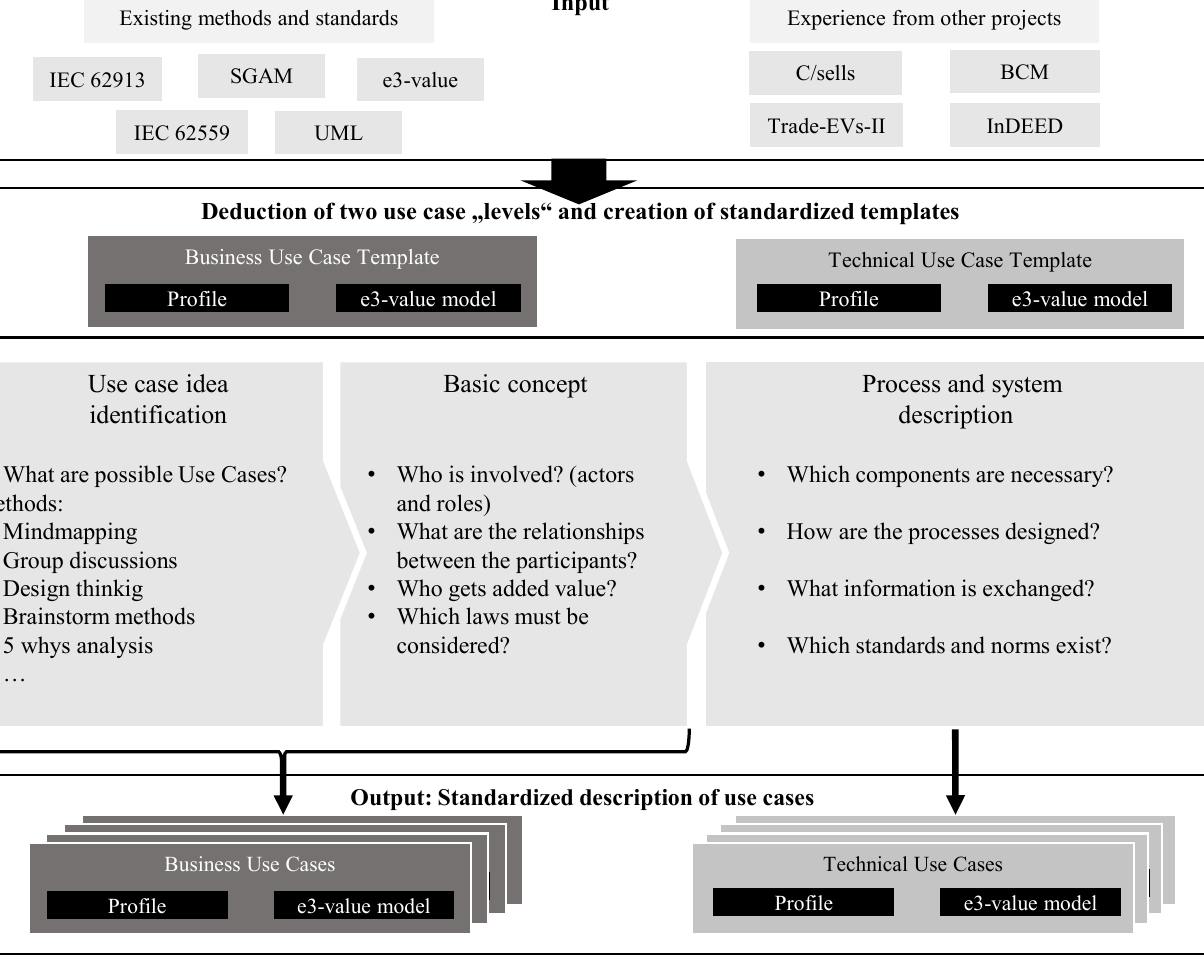
Figure 1. unIT-e 2 use-case methodology.